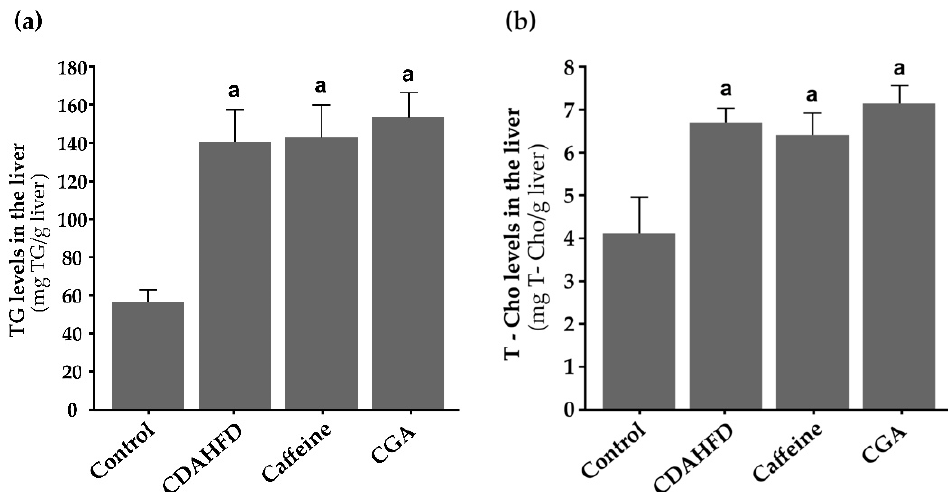
Figure 2. Triglyceride (TG) and total cholesterol (T-Cho) levels in the liver ( a , b ). ( a ) TG levels in the liver are significantly higher in the CDAHFD, caffeine, and CGA groups than in the control group and tend to be higher in the caffeine and CGA groups than in the CDAHFD group. ( b ) T-Cho levels in the liver are significantly higher in the CDAHFD, caffeine, and CGA groups than in the control group, but caffeine or CGA does not significantly influence them. Generally, hepatic TG levels are 15– 20-fold higher than hepatic T-Cho levels. a Significantly different from the control group ( p < 0.05).